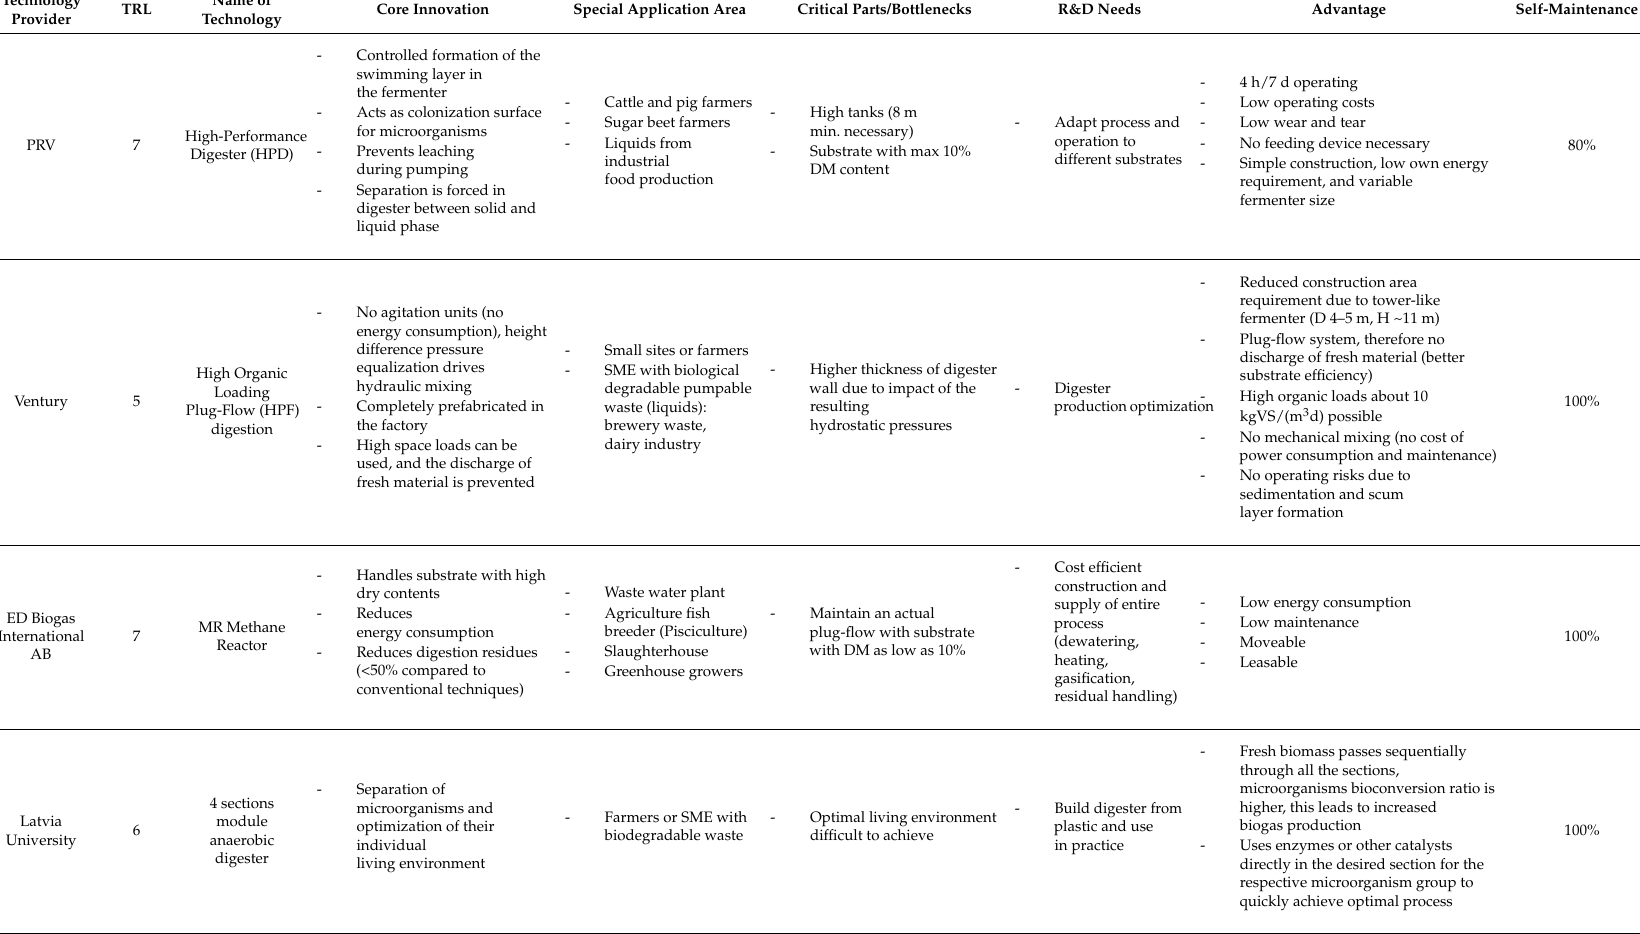
Table A2. Additional information for digestion